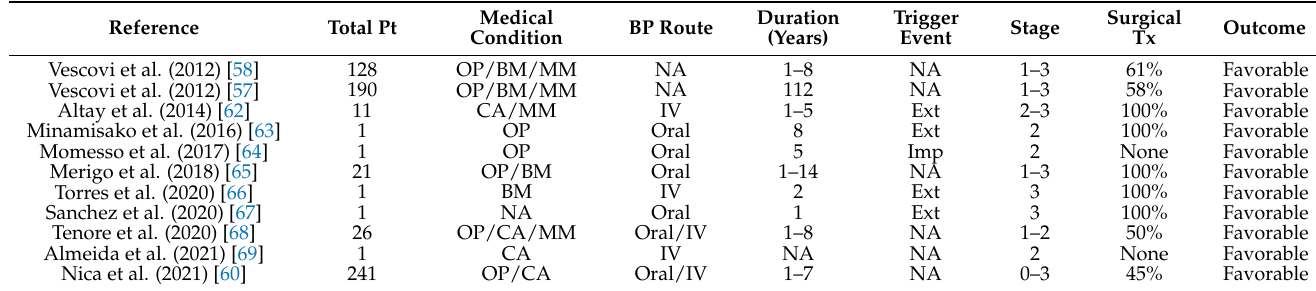
Table 4. Recent human studies on photobiomodulation (PBM) therapy for